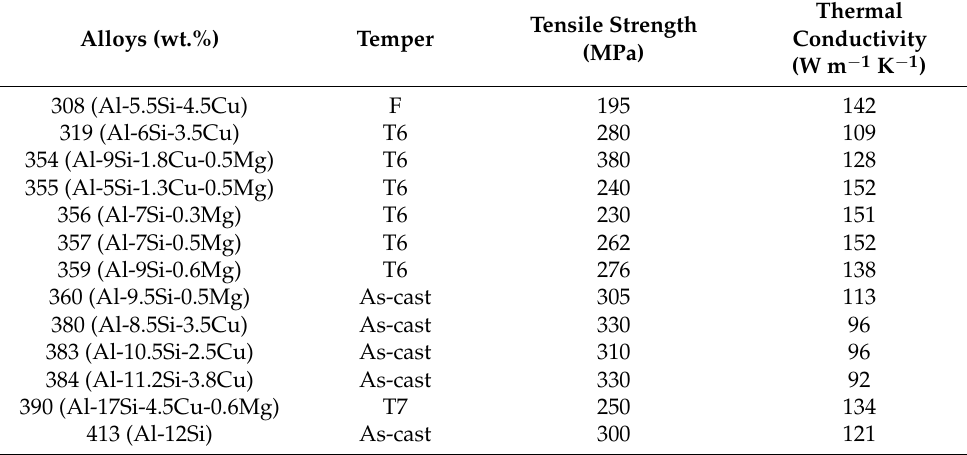
Table 1. Thermal conductivity and tensile strength of cast Al-Si alloys at 298 K [2]. Alloys (wt.%) Temper 308 (Al-5.5Si-4.5Cu) F 195 142